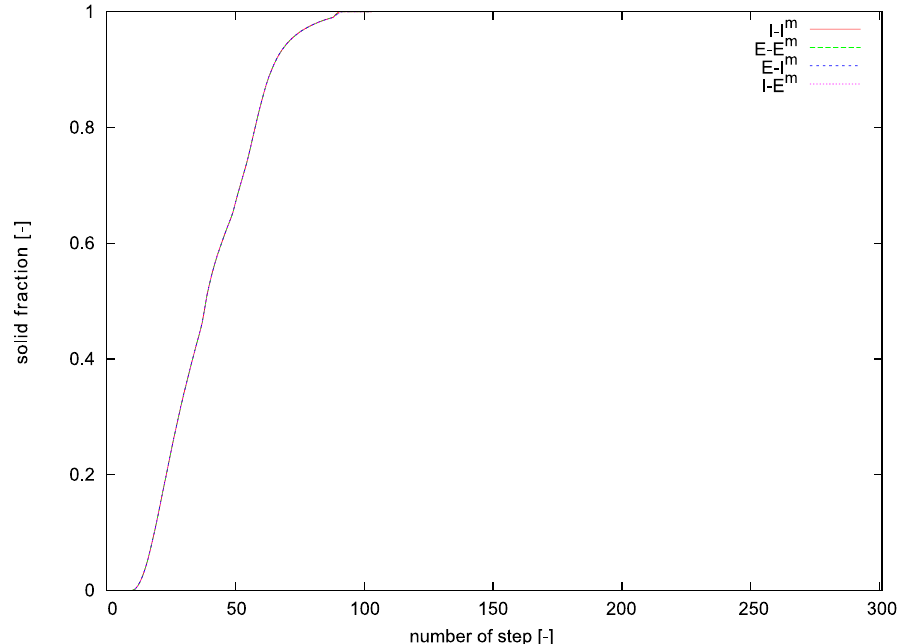
Figure 10. Cooling curves obtained for selected point in casting domain. Temperature distribution for multiplication factor m = 15 calculated by mixed time partitioning methods.